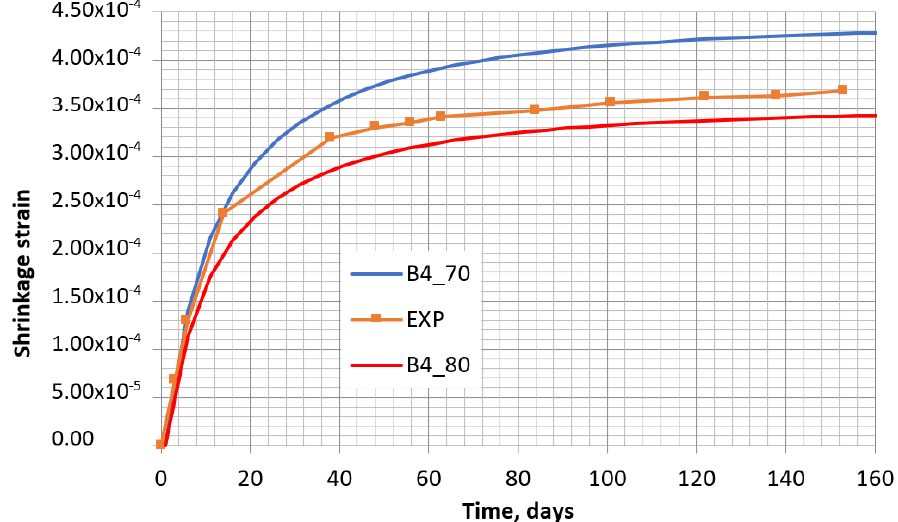
Figure 8. Shrinkage of the control specimen obtained experimentally (EXP) and by B4 model, at humidity of 70% (B4_70) and 80% (B4_80).